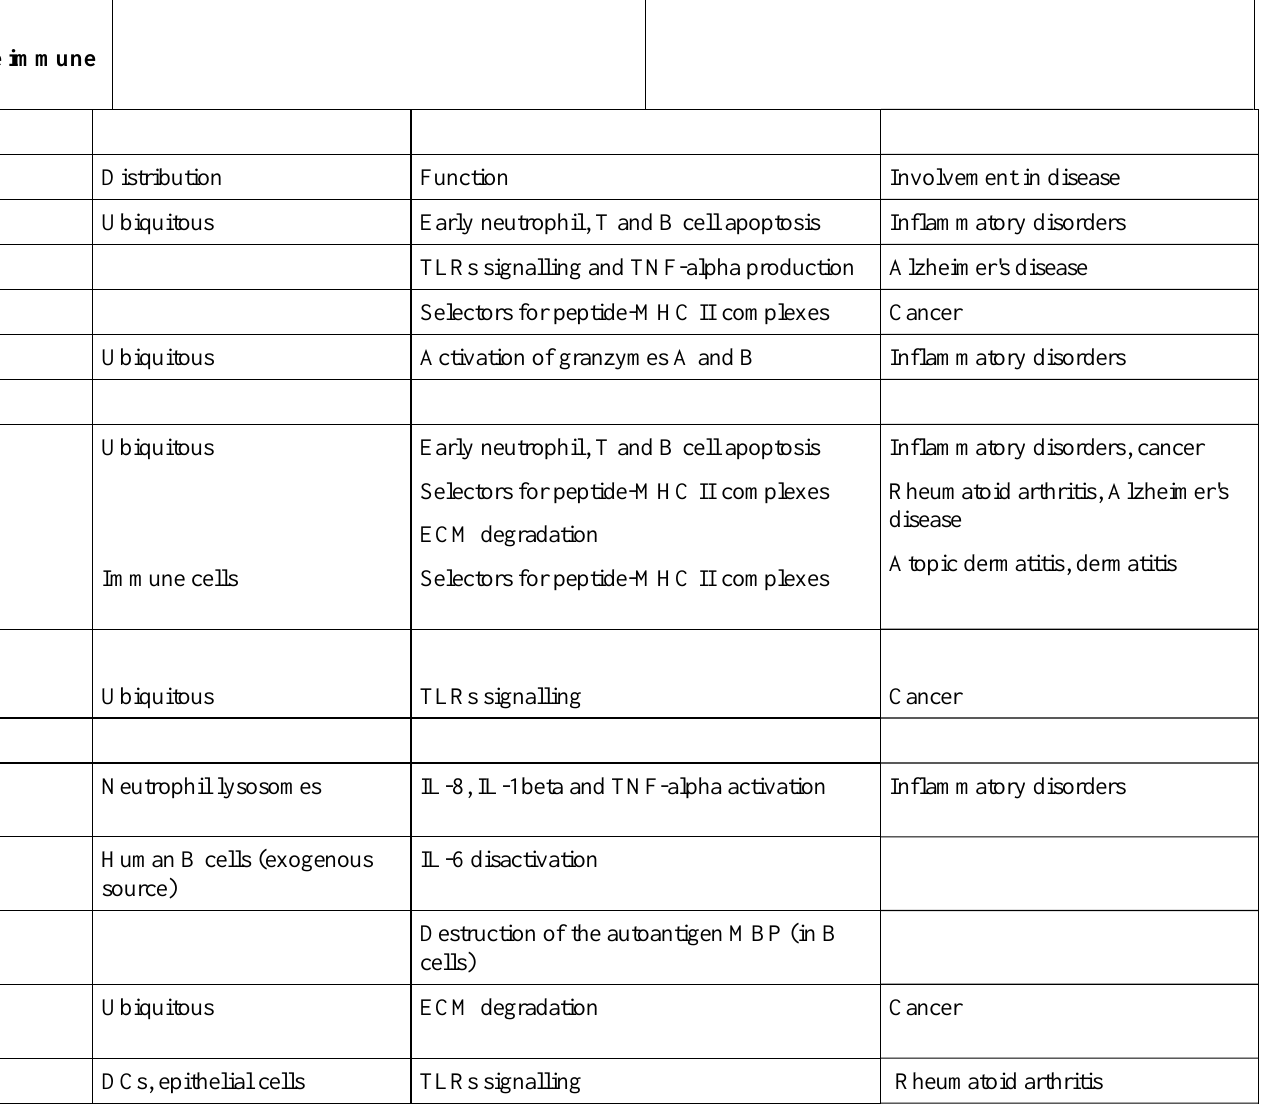
Table 1 Cathepsins and their functions in the immune